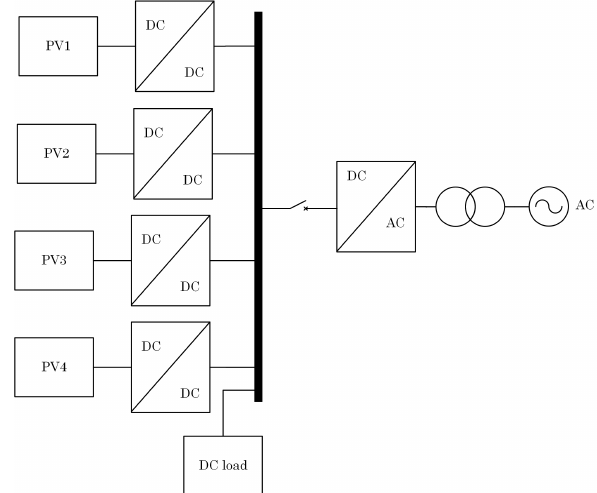
Figure 12. Multi-PV operation.